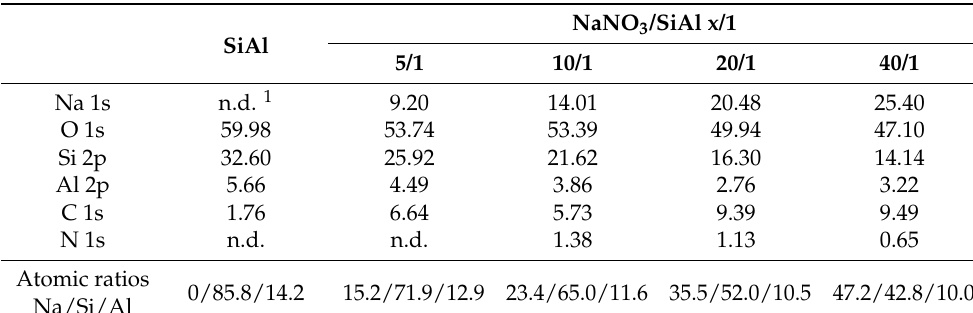
Table 4. Surface quantification and atomic ratio for support and